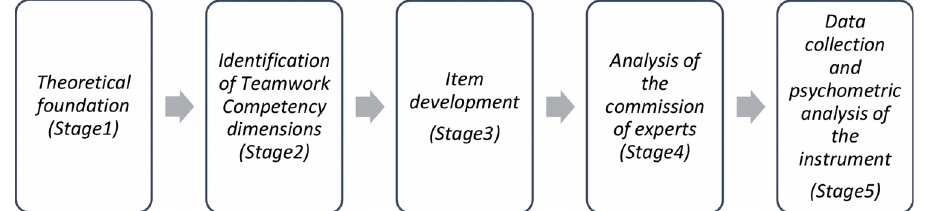
Figure 1. Scale creation